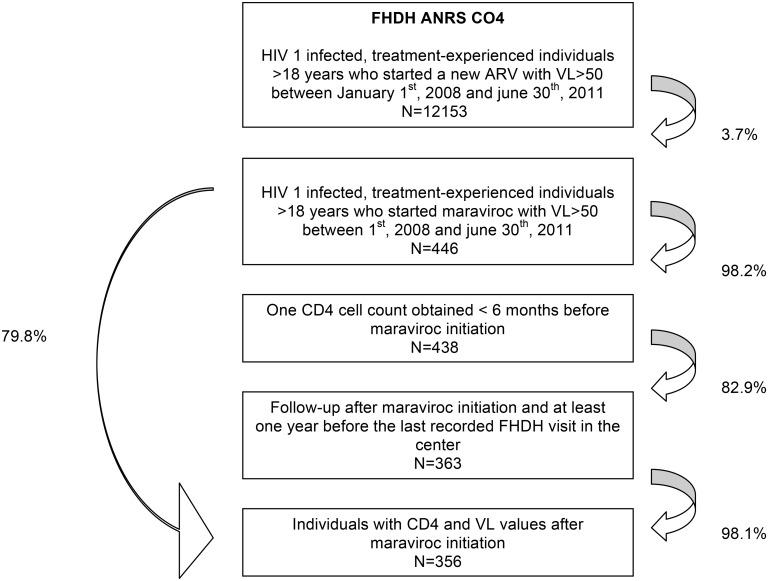
Individual selection.